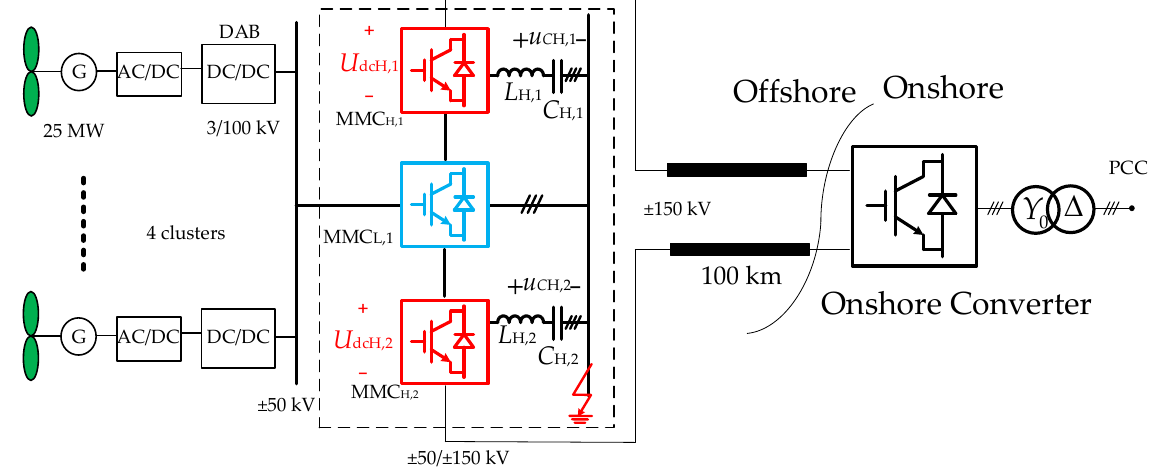
Figure 5. Diagram of the simulation system. Table 2. Parameters of the aggregated WT.